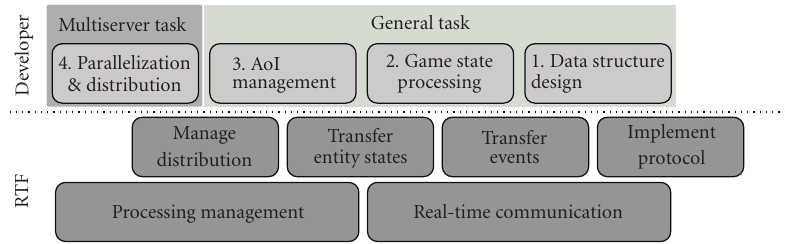
Figure 6: Development tasks for a multiserver game: distribution between RTF and developer.